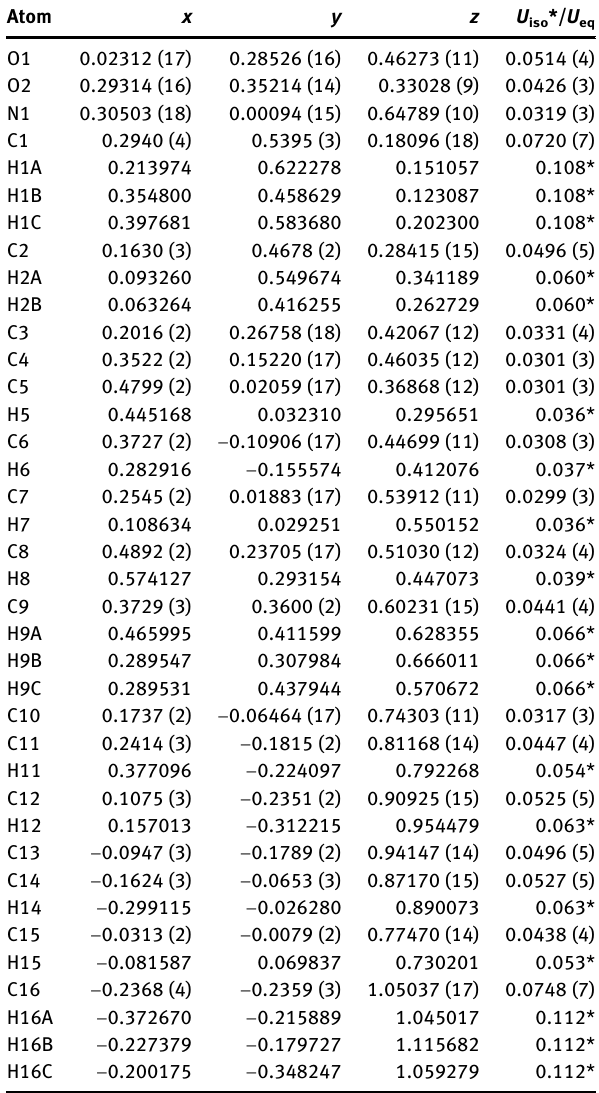
Table  : Fractional atomic coordinates and isotropic or equivalent isotropic displacement parameters (Å 